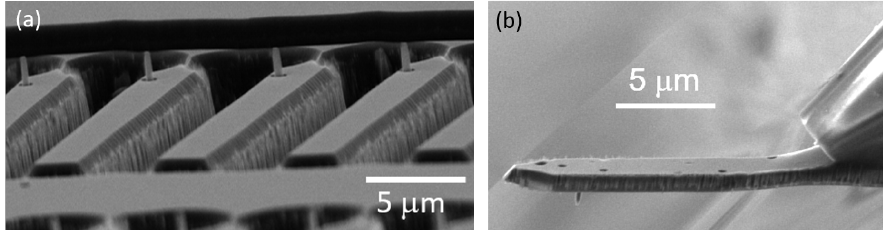
Figure 5. Scanning probe devices manufactured using the described nanofabrication process. ( a ) Pillars on platforms. The shown devices still need thinning of the SCD plate from the backside to release the devices. ( b ) Mounted SCD scanning probe. On the right hand side, a quartz capillary is visible that serves as a holder to mount the device to a scanning probe